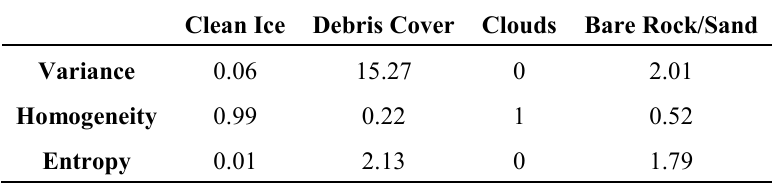
Table 4. Mean statistics for three texture indices (co-occurrence values) for the Zemu subset image. Statistics are derived from the regions of interest (ROIs) shown in Figure